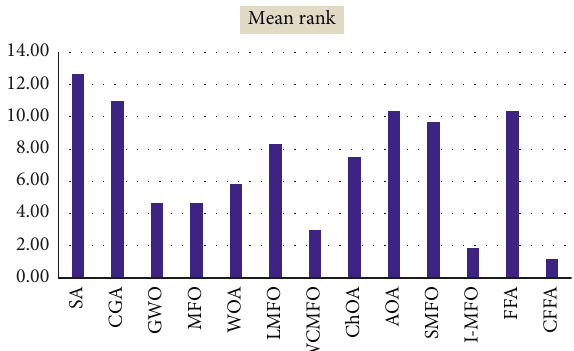
Figure 11: The Friedman test ′ s mean-ranking on CFFA and its 11 competitors. Table 8: The results of Wilcoxon ′ s signed-rank test for the engineering design problems. Test